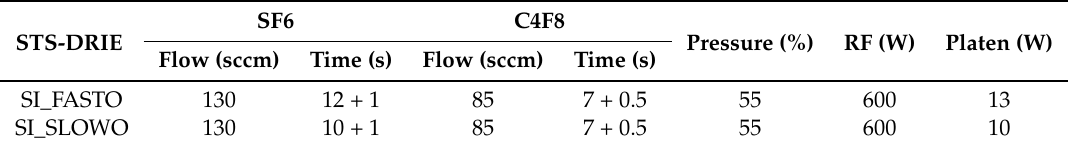
Table A1. Etch recipes used in the STS-ICP plasma